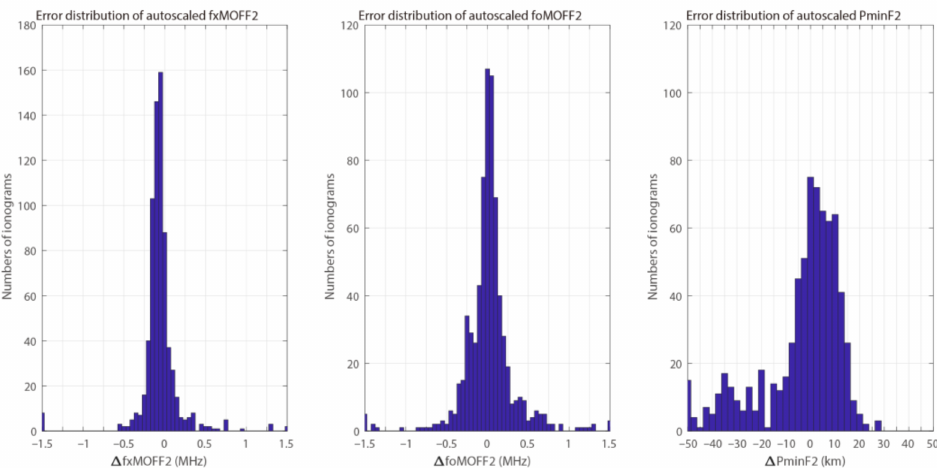
Figure 9. Error distributions of fxMOFF2, foMOFF2, and PminF2 for oblique ionograms between the manual and autoscaled values.